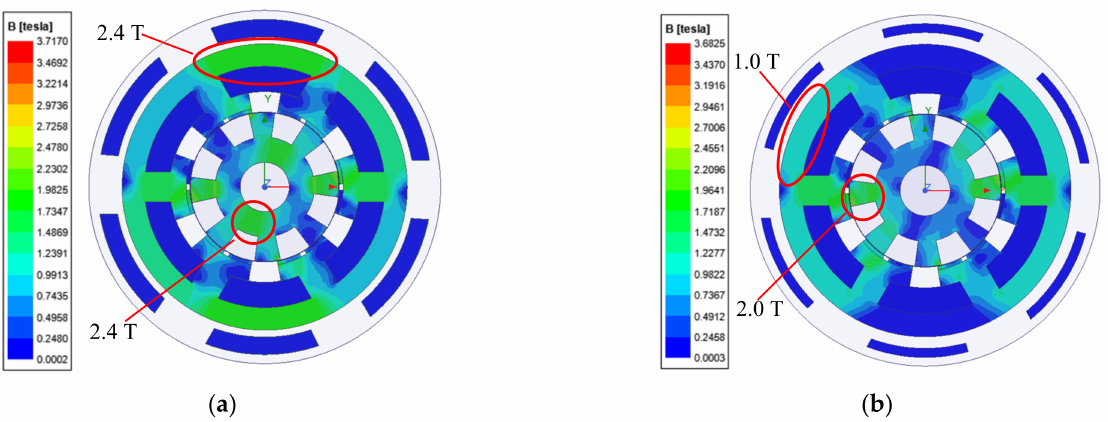
Figure 19. Flux density distributions for AM-FRPM machines. ( a ) AMA-FRPM. ( b ) AMC-FRPM.